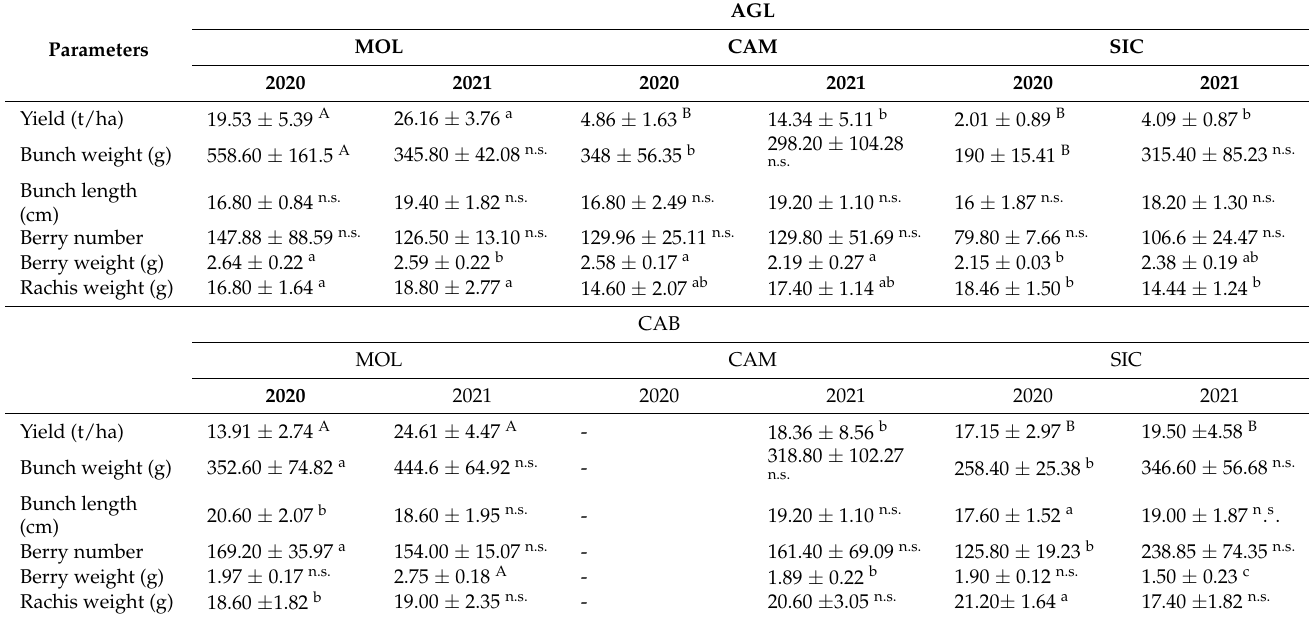
Table 4. Yield and its components in each of two cultivars, Aglianico (AGL) and Cabernet Sauvi- gnon (CAB), grown in three different sites, Molise (MOL), Campania (CAM), and Sicily (SIC). Measurements were made when all inflorescences were fully developed (Biologische Bundesanstalt, Bundessortenamt and Chemical industry: inflorescence 57). Mean values for each parameter and years indicated by different letters are significantly different (lowercase letter p ≤ 0.05, uppercase letter p ≤ 0.001, n.s. not significant ± indicates one standard deviation), based on Tukey’s HSD test within years and